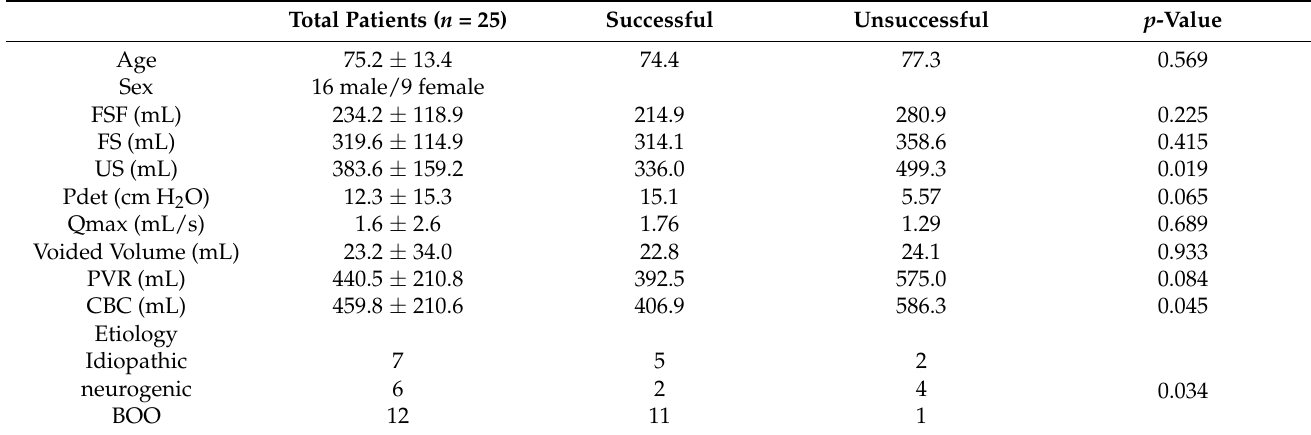
Table 1. Clinical parameters of patients with DU with different treatment outcomes. Total Patients ( n = 25)